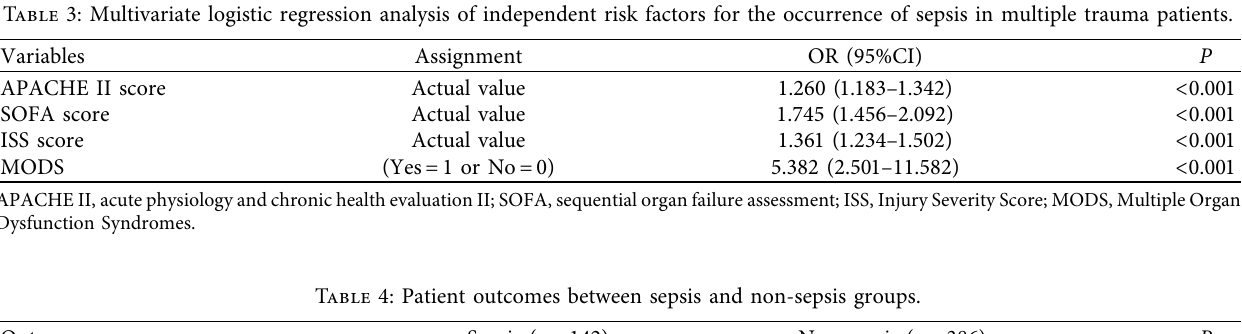
Table 4: Patient outcomes between sepsis and non-sepsis groups.